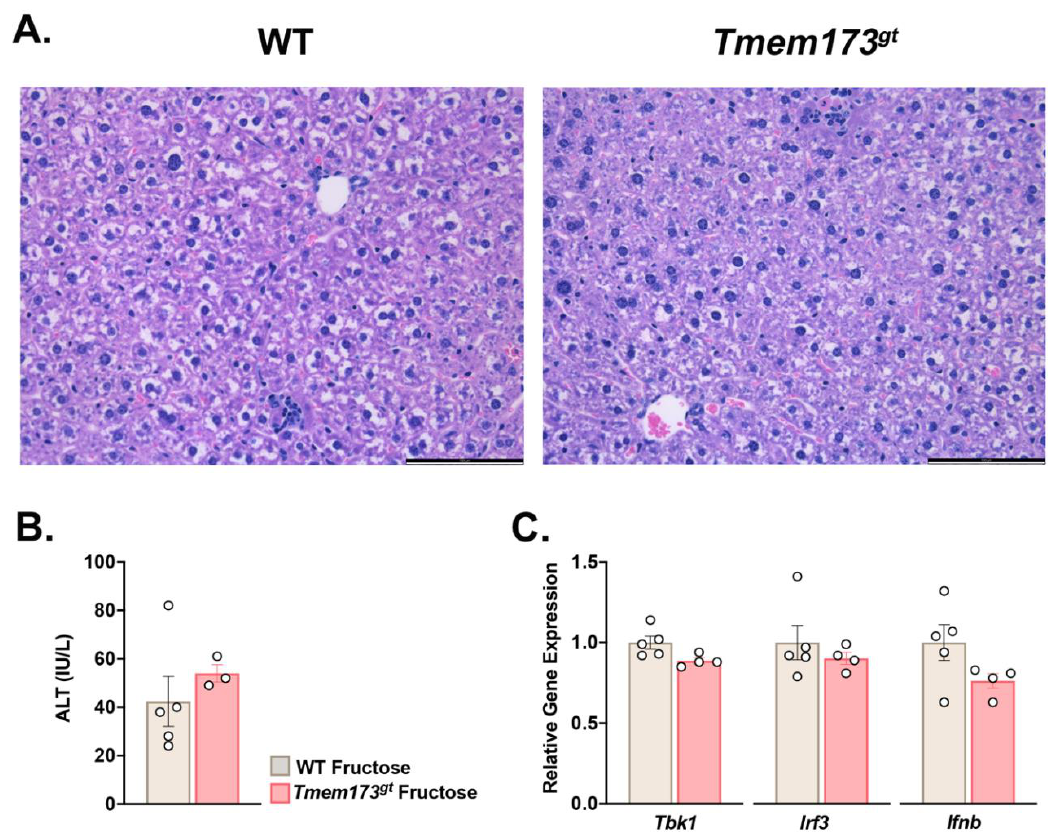
Figure 2. Liver histology in WT and STING-deficient mice after 4 wk of high-fructose feeding. ( A ) Representative photomicrographs of H&E-stained livers of high-fructose fed WT and Tmem173 gt mice. Chow livers, not shown, showed no abnormalities. Bar size = 100 µ m. ( B ) ALT levels of WT and Tmem173 gt mice fed a high-fructose diet for 4 wk. ( C ). Relative gene expression levels for Tbk1 , Irf3 , and Ifnb for WT and Tmem173 gt mice. Graphs represent means ± SEM.